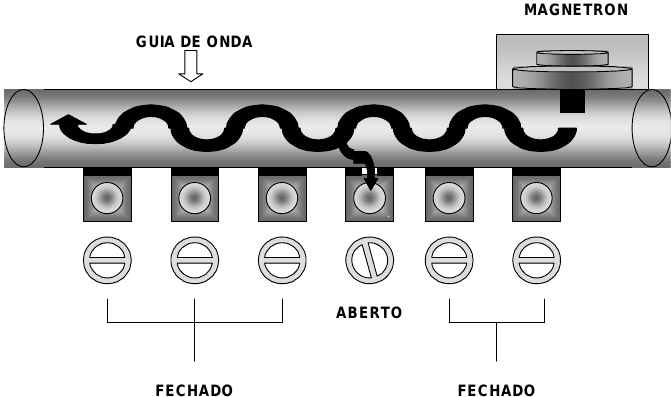
Figura 1. Esquema do guia de ondas do forno de microondas com radiação focalizada equipado com um único